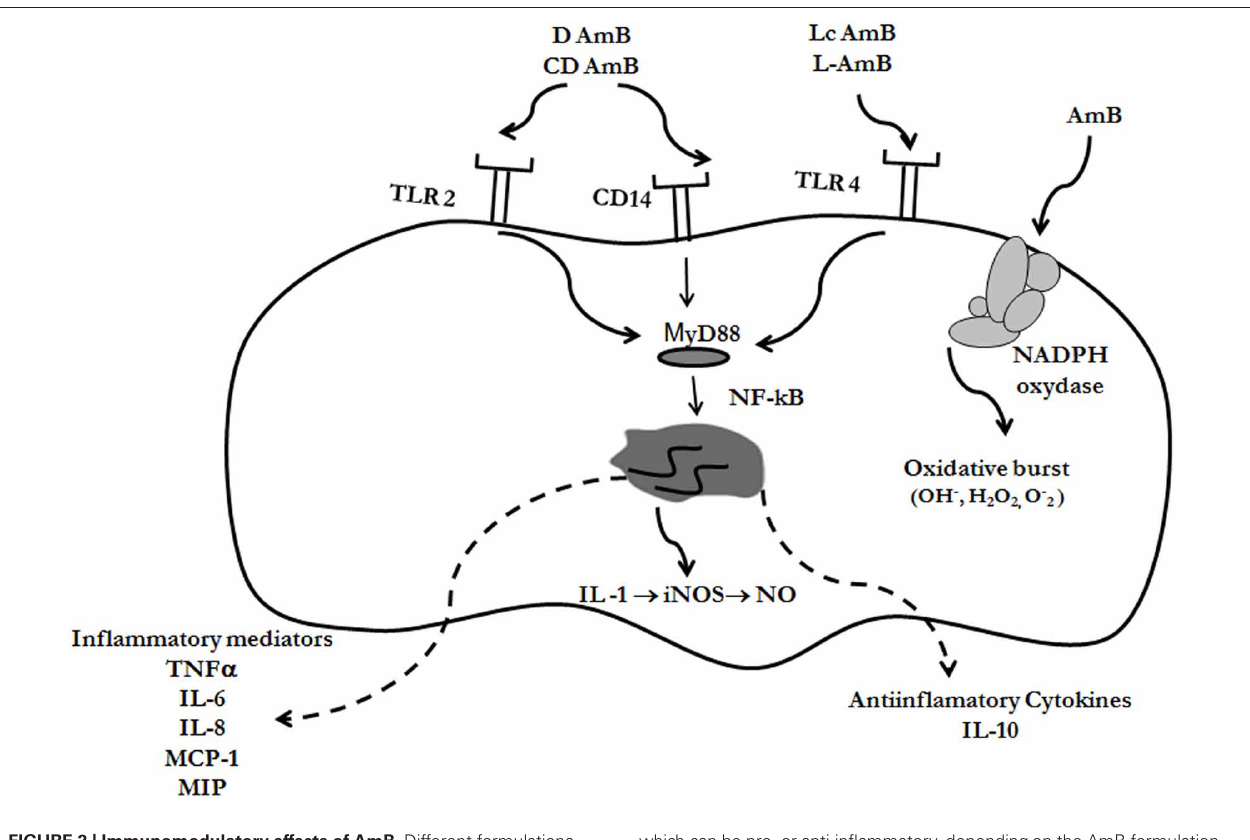
which can be pro- or anti-inflammatory, depending on the AmB formulation, and receptors involved (see text for further details). AmB also induce the accumulation of free radicals (reactive oxygen intermediates, ROIs, and nitric oxide, NO) through induction of NO synthase and NADPH